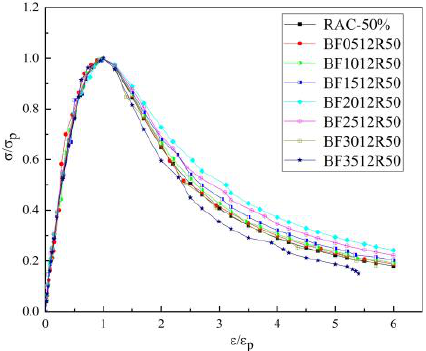
Figure 15. Full stress – strain curve of BFRC under compression.